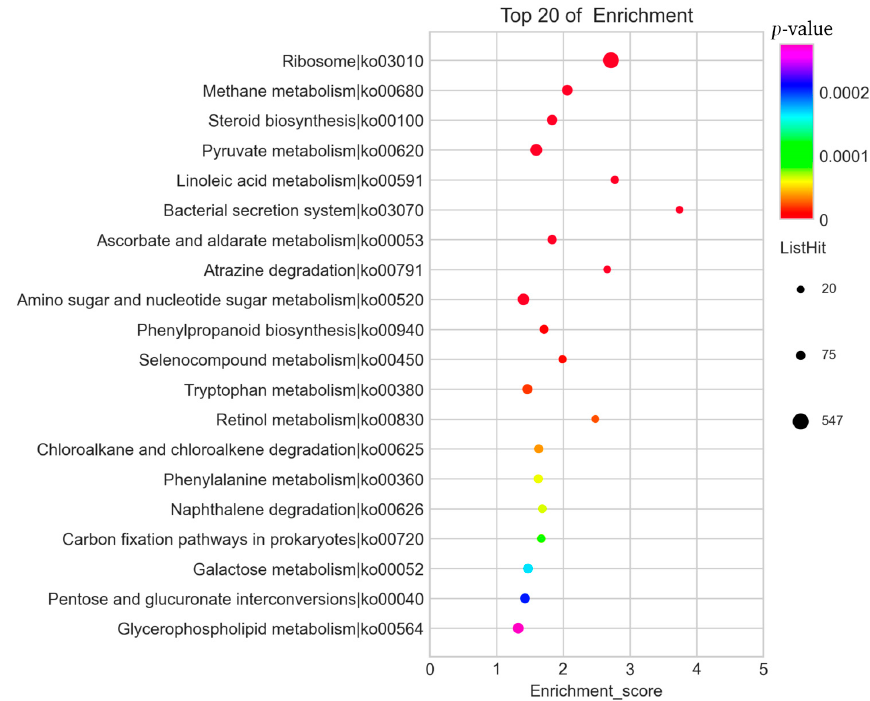
Figure 4. The top 20 KEGG enrichment pathways of DEGs. The Y -axis shows the KEGG pathway and the X -axis shows the enrichment score. High p -values are shown in purple and low p -values are shown in